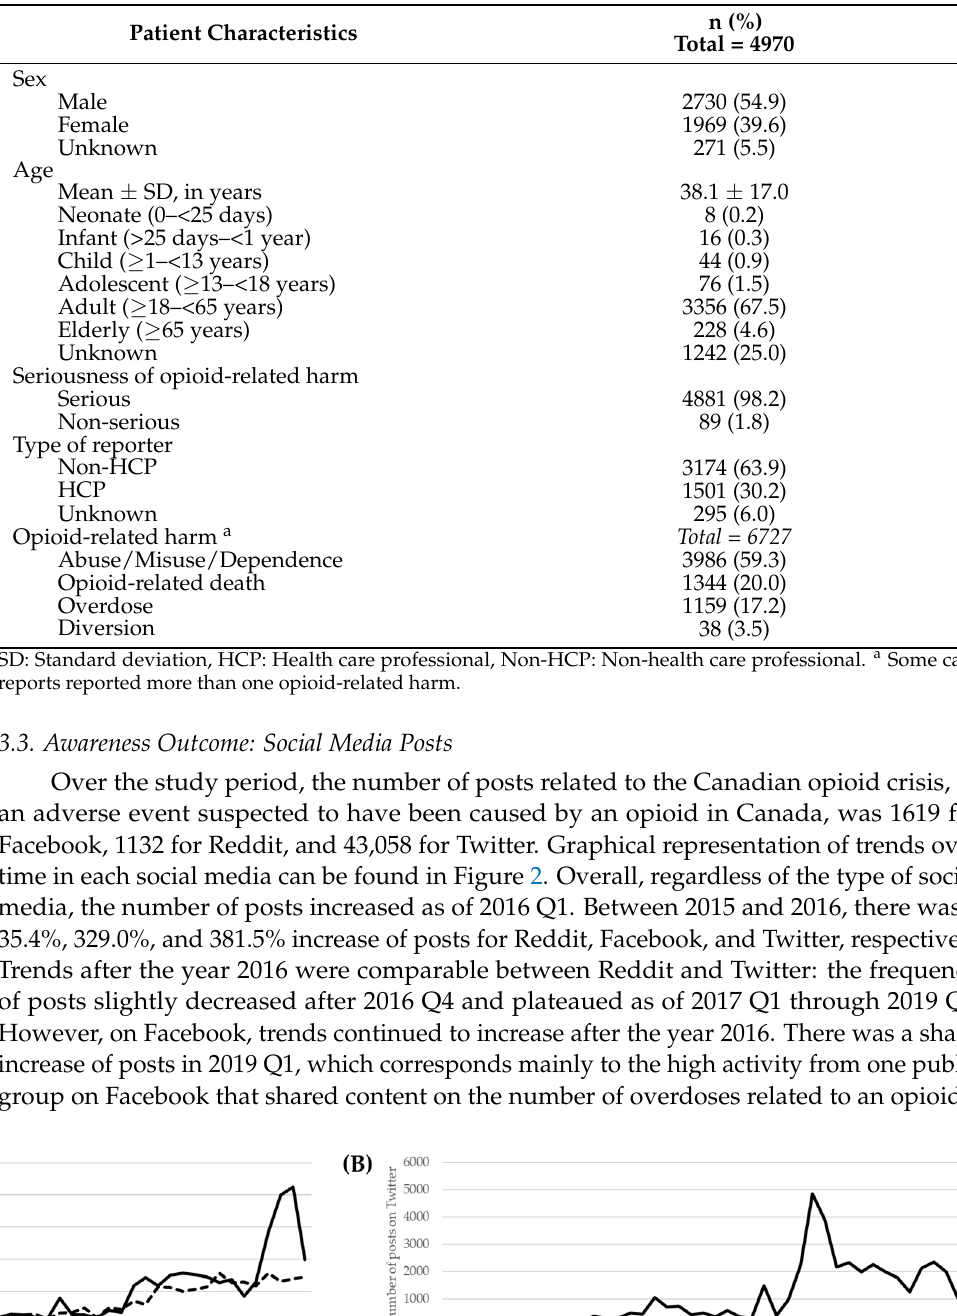
Table 2. Characteristics of patients and reporters of opioid-related harm cases reported to Canada Vigilance between 2009 and 2019.